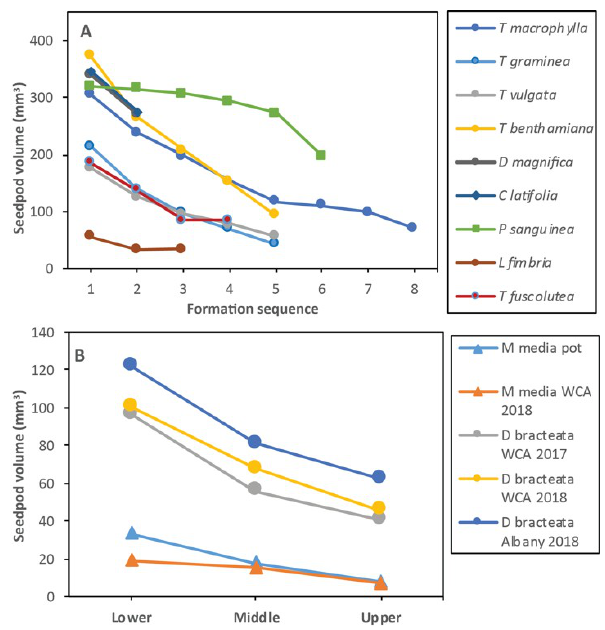
Figure 8. Comparisons of capsule sizes relative to formation sequence ( A ) or between upper, middle and lower flowers from self-pollinating orchids with numerous flowers ( B ).